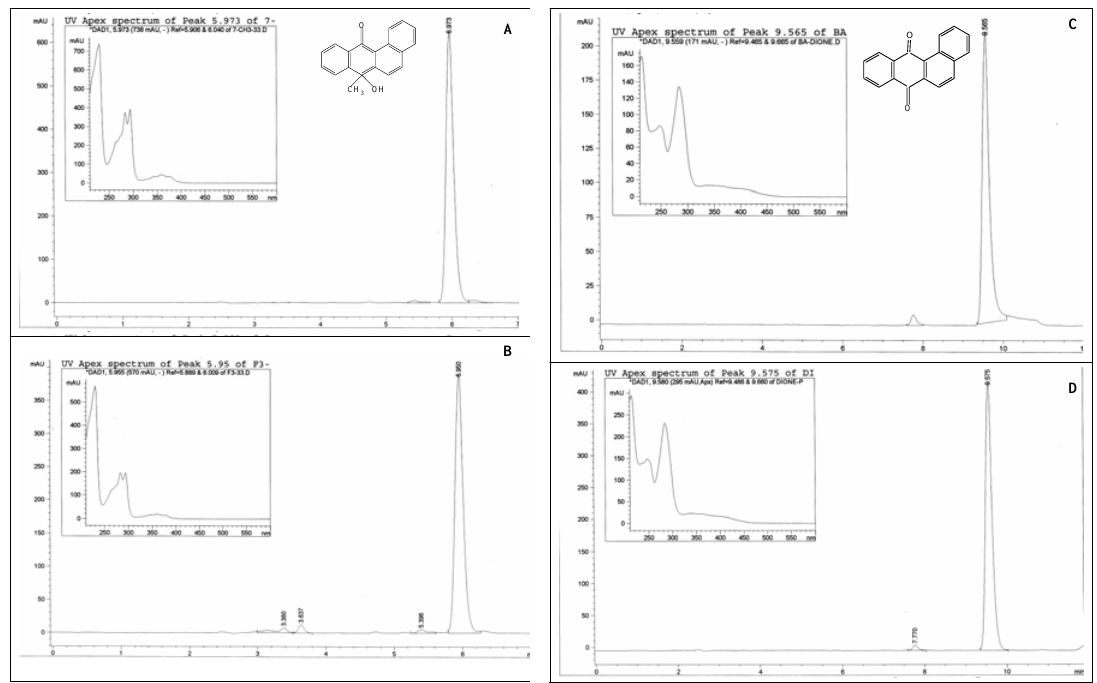
Figure 5: HPLC and UV spectrum profiles of 7-hydroxymethyl-12-methylbenz[ a ]anthracene standard (A), purified P6 from DMBA photoproducts (B); benz[ a ]anthracen-7,12-dione standard (C), and purified P9 from DMBA photoproducts (D).